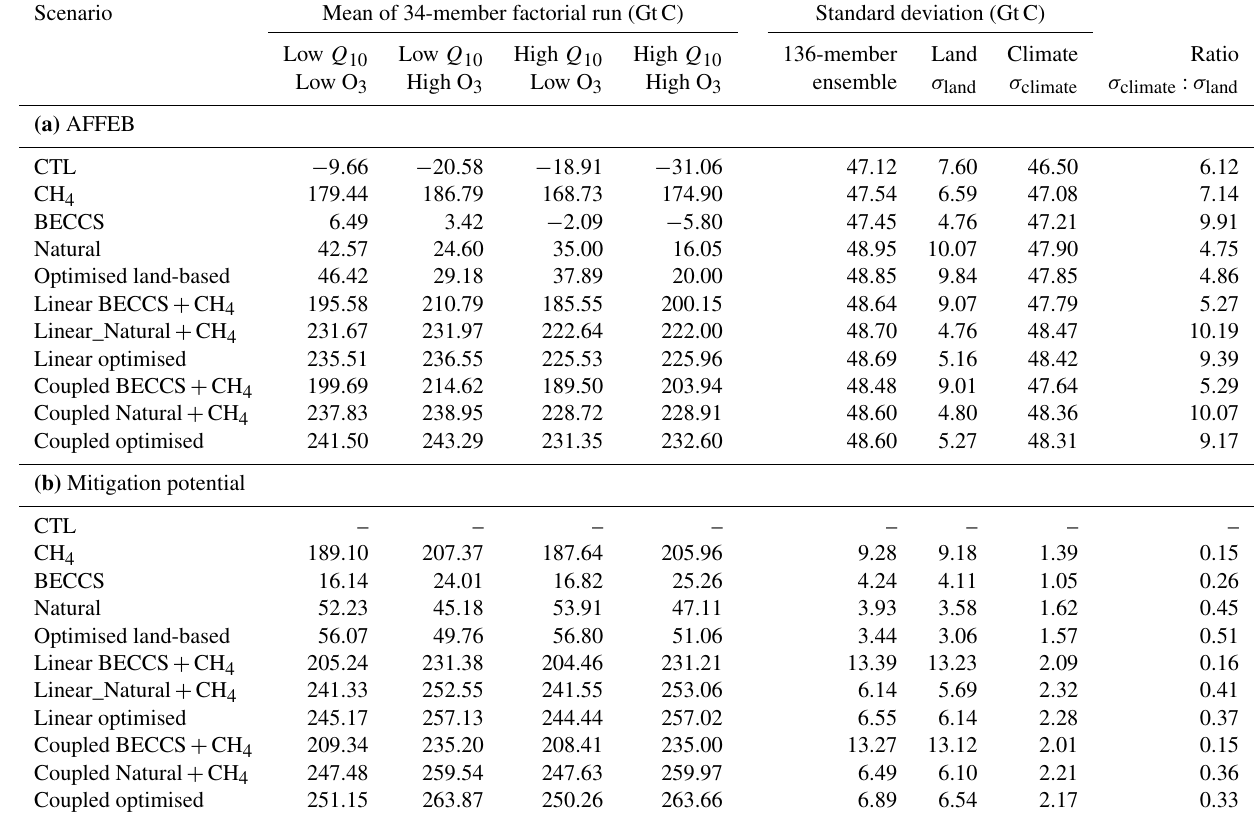
Table 3. For the 1.5 ◦ C temperature profile, the mean of the 34-GCM member ensembles for the CTL and mitigation scenarios for the different factorial runs (low Q 10 /low O 3 , low Q 10 /high O 3 , high Q 10 /low O 3 and high Q 10 /high O 3 ), the standard deviation of the full 136- member ensemble (GtC), the derived standard deviations for land processes ( σ land ) and climate ( σ climate , as represented by the 34 GCMs) and the ratio of σ climate /σ land for (a) the Anthropogenic Fossil Field CO 2 Emission Budgets and (b) the Mitigation Potential ( = scenario −